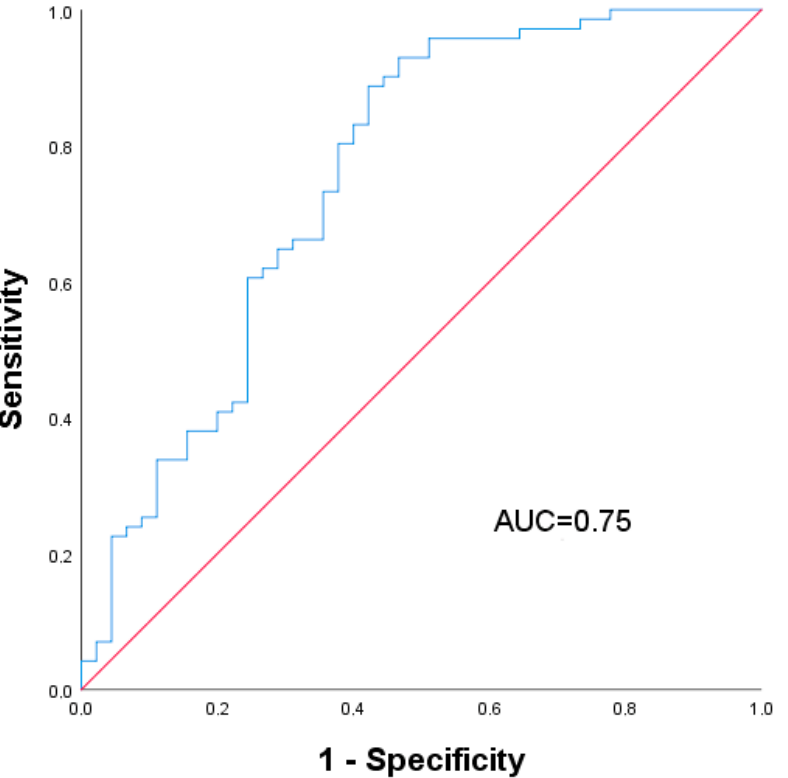
Figure 2. ROC curve analysis of the ANN model predicting hypertrophy > 25% after